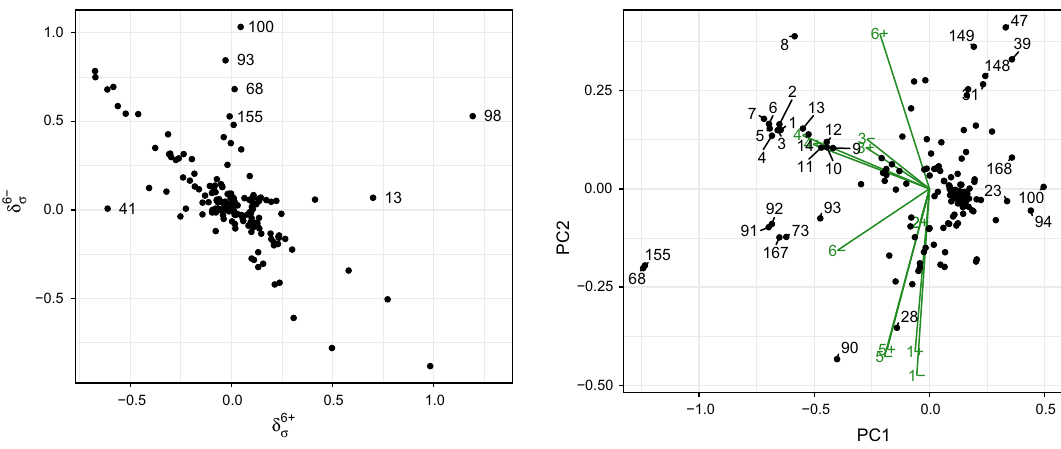
Fig. 9 Comparison of distribution in δ 6 + σ and δ 6 − σ , where observables with the largest deviation from anticorrelated behaviour are labeled (left ) in the space of the first two principal components capturing most of the total variance in the distribution (right panel). Illustration of (cid:11)(δ ± i